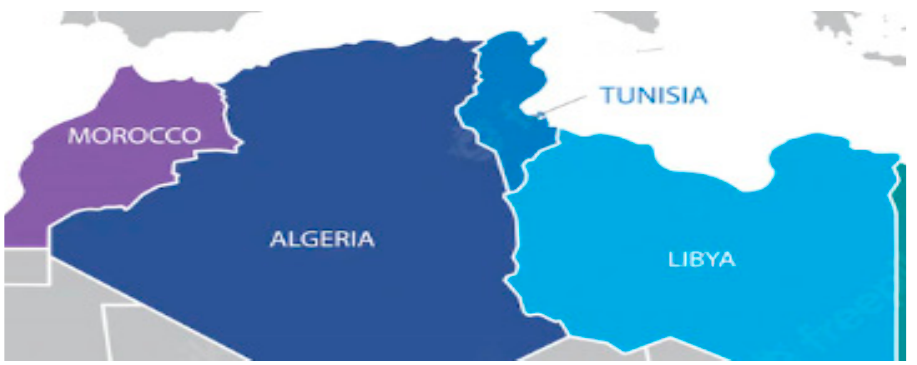
Figure 1. Map of Tunisia and neighbors. The image was taken from https://www.freepik.com/free- photos-vectors/Tunisia-map under open license (accessed on 23 September 2022) .